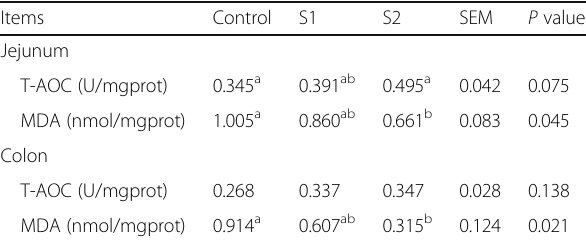
Table 6 Effect of gastric infusion of SCFA on antioxidant capacity of jejunum and colon in weaned